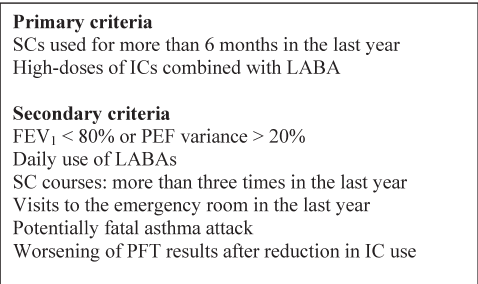
Figure 4 - Criteria for the diagnosis of difficult-to-control asthma. SC: systemic corticosteroid; IC: inhaled corticosteroid; LABA: long-acting b 2 agonist; FEV 1 : forced expiratory volume in one second; PEF: peak expiratory flow; PFT: pulmonary function